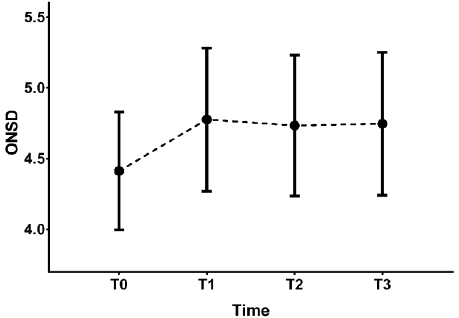
Figure 3. Changes in ONSD during robot-assisted laparoscopic prostatectomy. T0, 10 min after anesthetic induction in the supine position; T1, 10 min after establishing pneumoperitoneum with steep Trendelenburg position; T2, 10 min after de-sufflation of pneumoperitoneum; T3, end of surgery in the supine Table 2. Intraoperative variables.